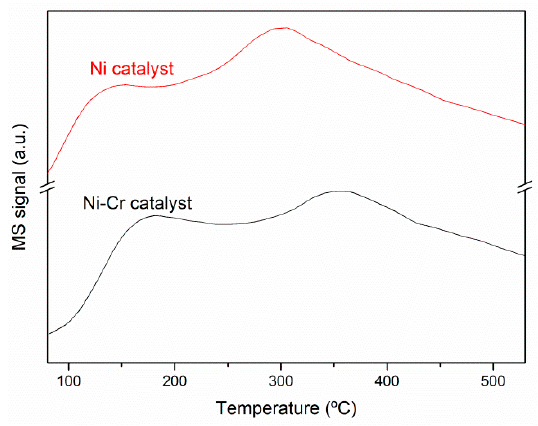
Figure 4. Ni K XANES of both Ni-based catalysts before and after in-situ temperature programmed reduction (TPR). Ni and NiO standards are shown for comparision ( left ). The results of the linear combination analysis of the XANES data taking during the TPR (right ).